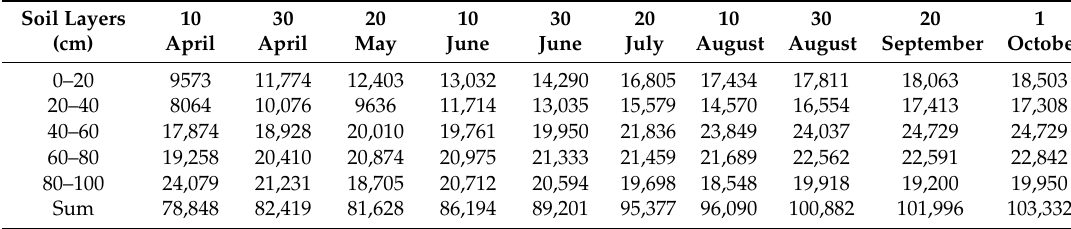
Table 11. Salt-storage changes at Site A3 in di ff erent periods (kg hm − 2 ). Soil